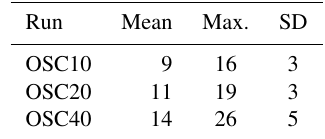
Table 1. The mean, maximum, and standard deviation in the depth of fan-head trenching (in mm) at an arcuate cross-section across the fan head placed at 0.25m down-fan. Depth estimates are accurate to within 1.5mm (90%